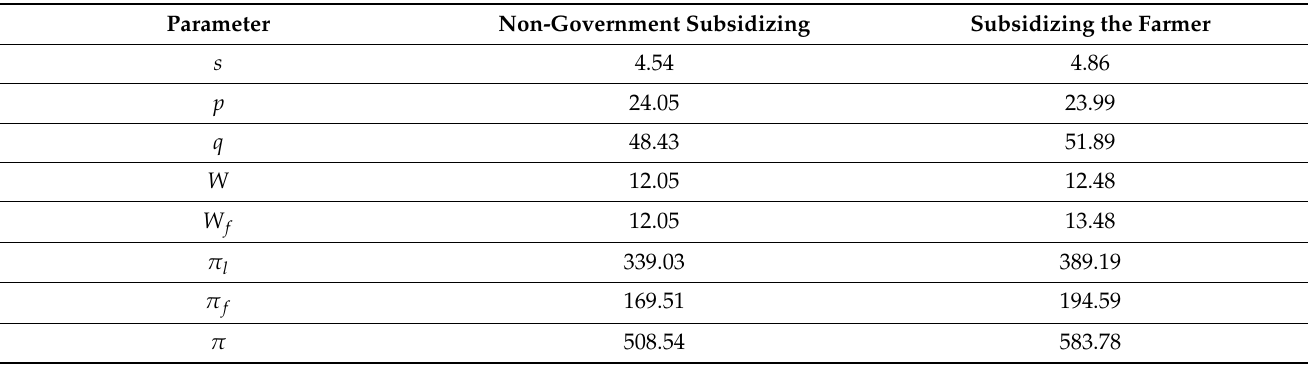
Table 7. Comparison of optimal decision-making and profit levels between government-subsidized a farmer and non-subsidized farmers.